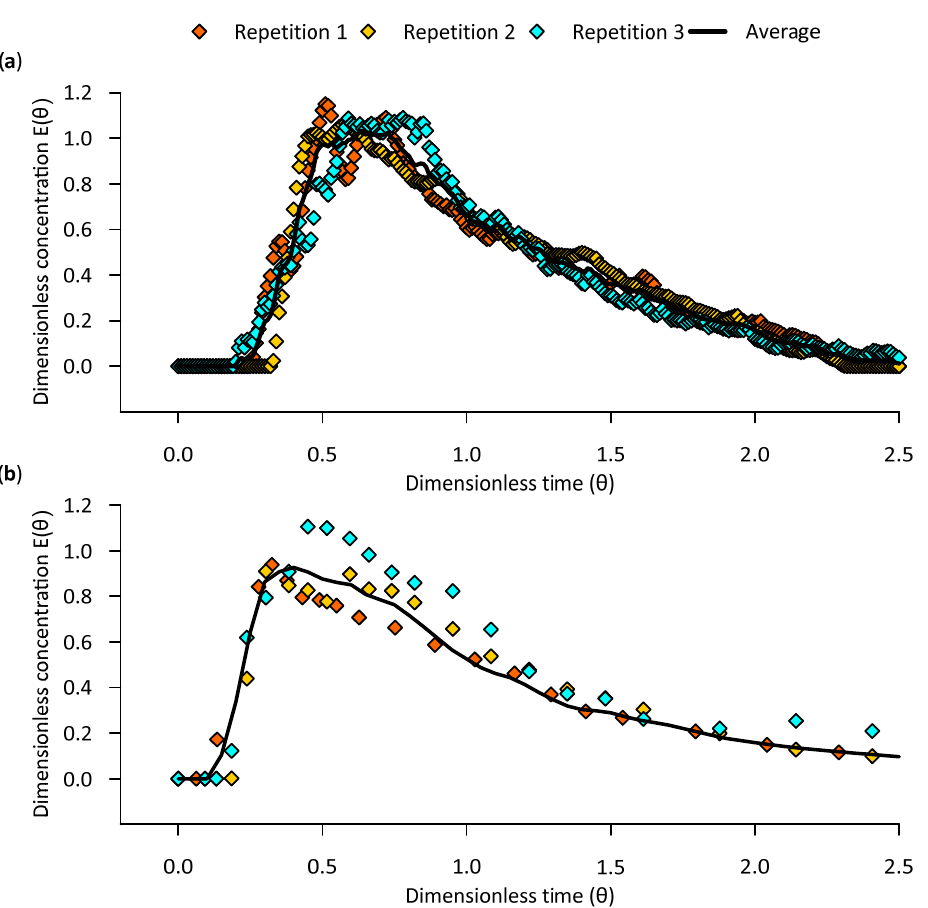
Figure 9. RTD curves comparison using automatic and manual techniques: ( a ) Results obtained using the automatic measurement system, ( b ) Results obtained using manual measurement techniques.